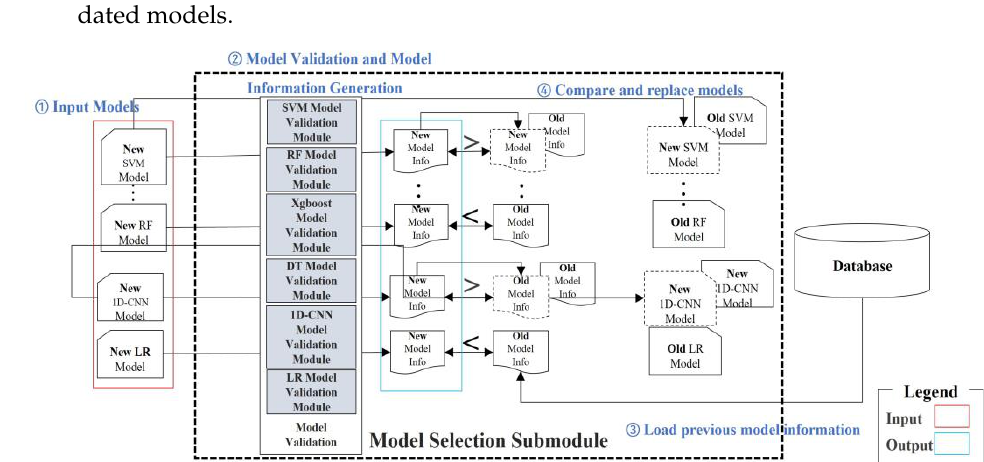
Figure 3. Machine Learning Model Selection and Replace Process.